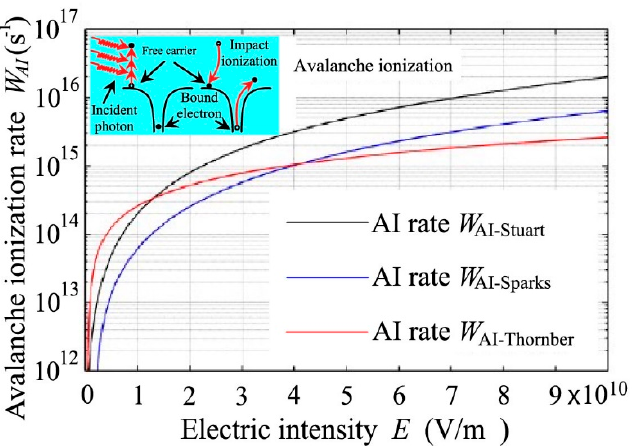
Figure 5. Dependence of avalanche ionization rate W AI on electric intensity E calculated by AI models of Stuart, Sparks, and Thornber of KDP [29].